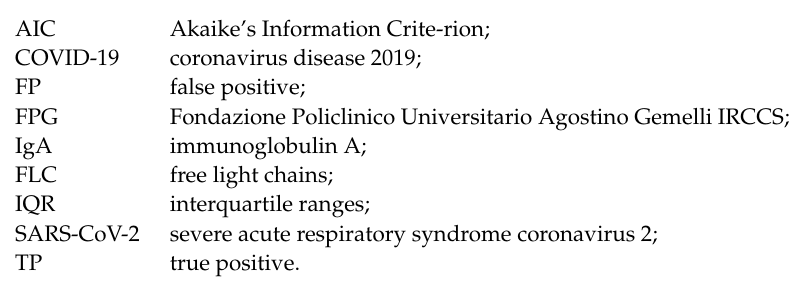
Figure 3, Table S1: Effect of comorbidities, symptoms at onset, complications and smoke on selected salivary biomarker